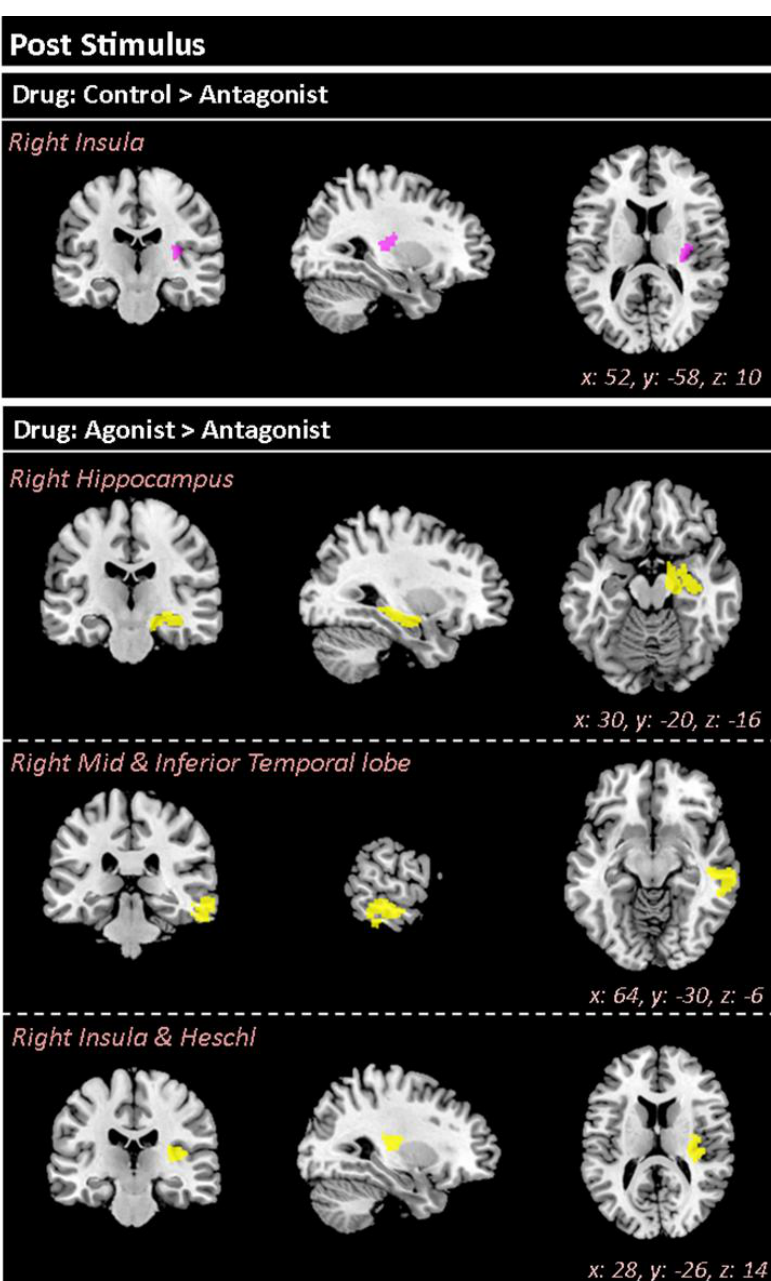
Figure 4. The drug effect reported using source localisation for post-stimulus TWOI [200 600 ms]. The TWOI was baseline corrected to − 500 ms prior to the noxious stimuli. There was a significant difference between the control and antagonist conditions, showing a lower degree of activity within the right insula in the antagonist condition. The antagonist condition also reported a lower activity in comparison to the agonist within the right hippocampus, mid/inferior temporal lobe, insula, and Heschl’s gyrus.